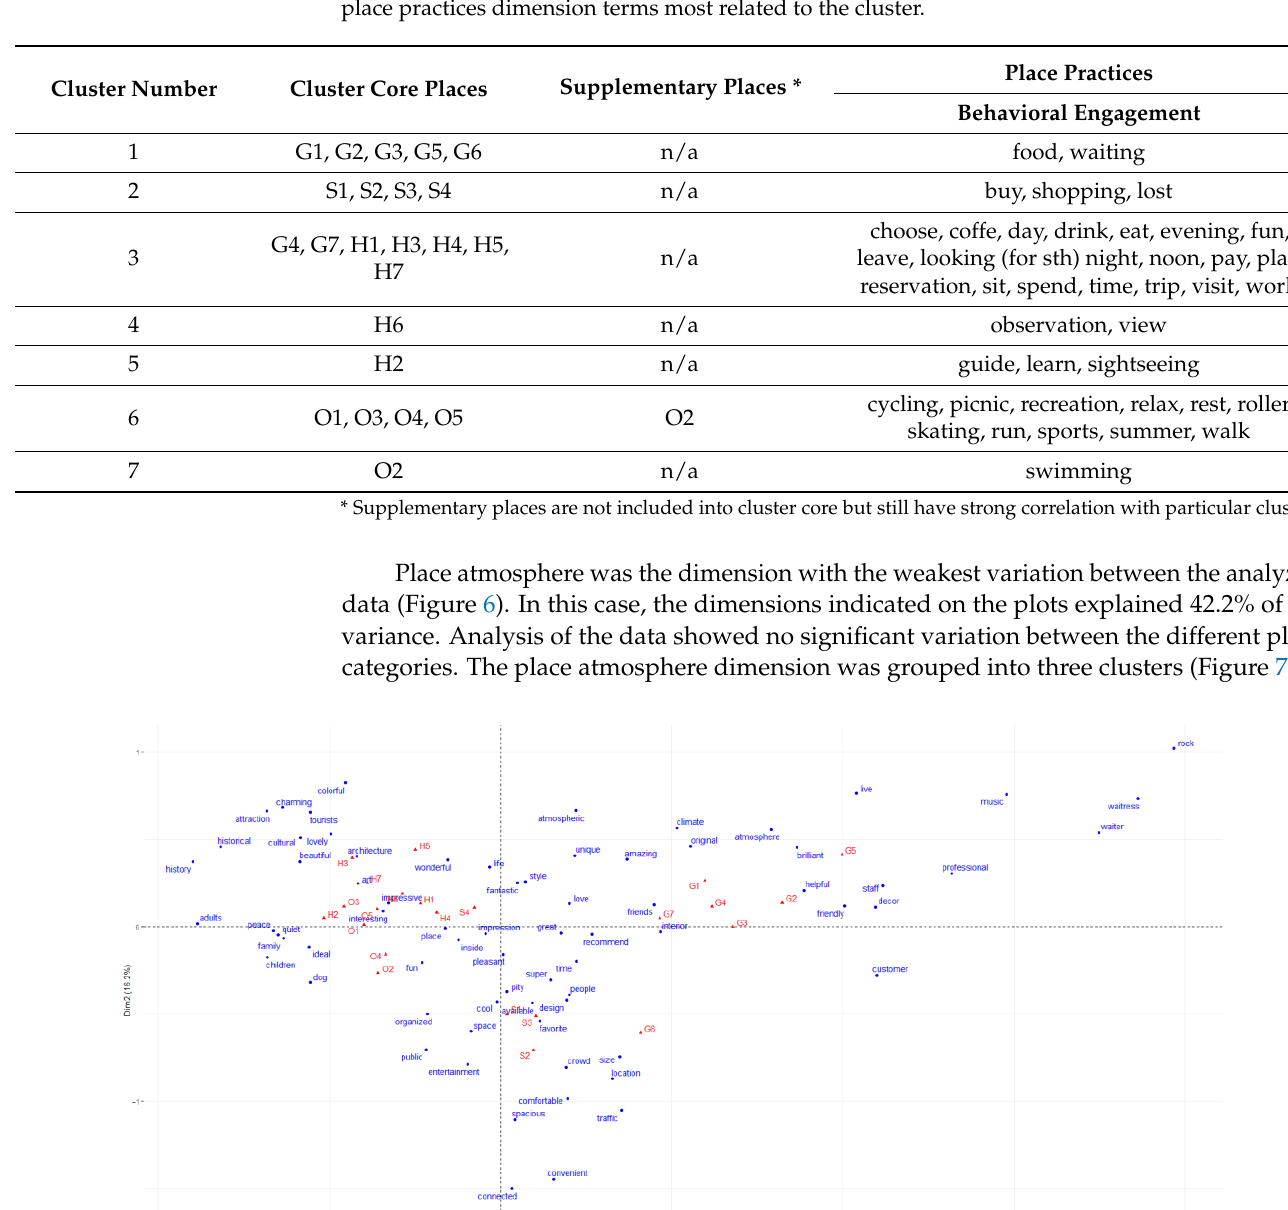
Table 6. Results of hierarchical clustering with regards to core and supplementary cluster places and place practices dimension terms most related to the cluster.